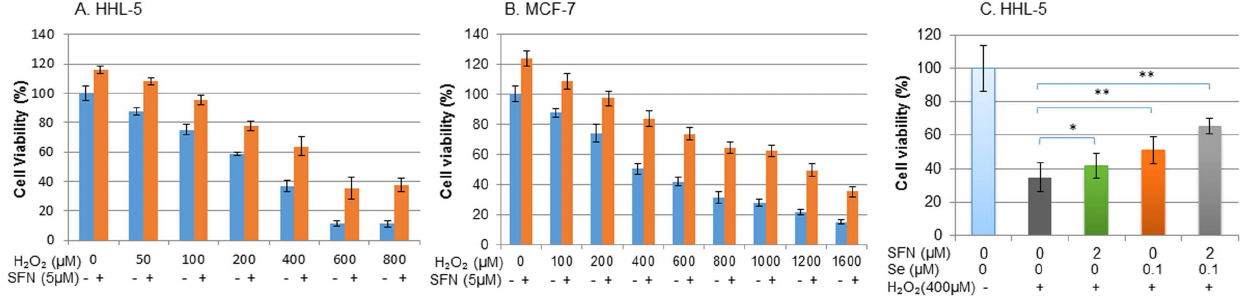
Fig. 4. Effect of pre-treatment of cells with SFN protect against H 2 O 2 -induced cell death. Cells were cultured in 96 well plates. When they reached 70– 80% confluence, cells were pre-treated with SFN (5 m M) for 24 h (HHL-5, A) or 48 h (MCF-7, B). The cell culture medium was replaced with H 2 O 2 at the concentrations indicated for a further 24 h. C: HHL-5 cell were pre-treated with SFN (2 m M) and Se (0.1 m M) for 24 h before exposure to H 2 O 2 (400 m M) for a further 24 h. The cell viability was measured using MTT assay. Statistical significance from corresponding controls: *p , 0.05; **p ,